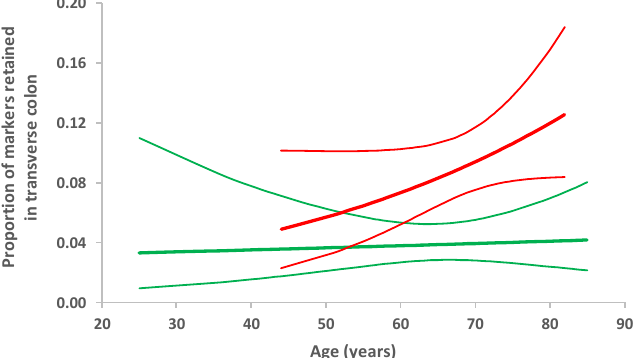
Figure 2. Estimated proportion of markers retained in the transverse colon by age, obtained from a generalised linear model including interaction between disease status and age. There is no evidence of any age trend in those without diagnosed PD (green), despite the wide age range: estimated odds ratio = 1.00 (95% CI: 0.97 to 1.04) per year. In contrast, in those with PD (red), there is some evidence of an increasing age trend: estimated odds ratio = 1.03 (95% CI: 1.00 to 1.06) per year. However, the interaction between PD status and age did not reach statistical significance, indicating either insu ffi cient sample size or a chance